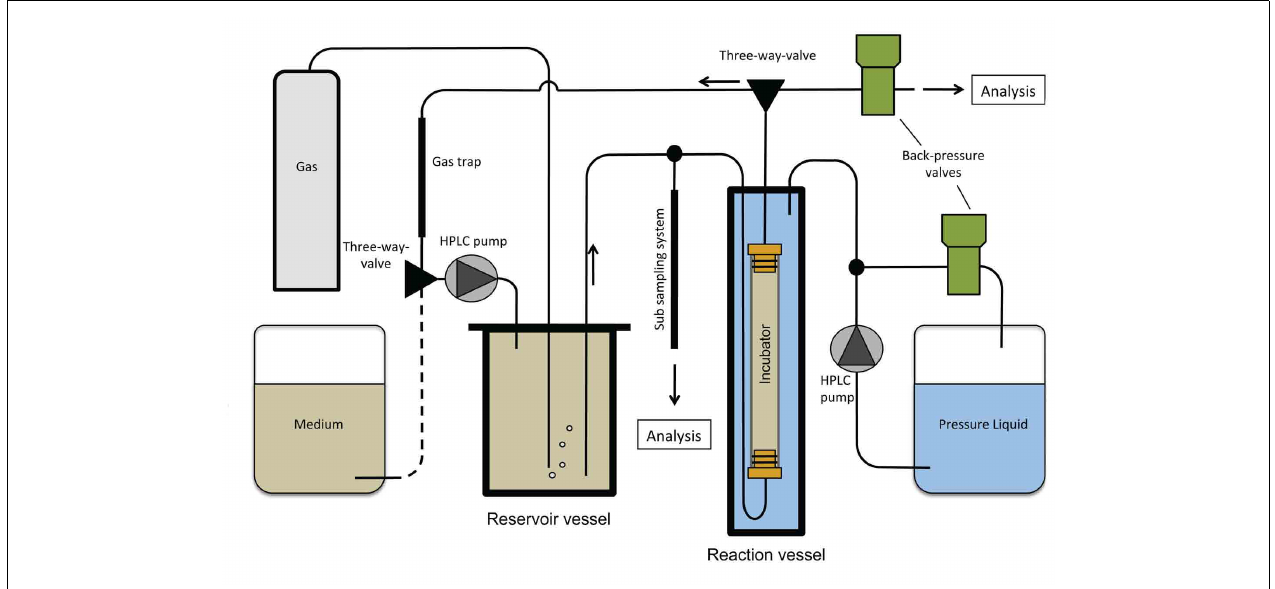
FIGURE 1 | Schematic drawing of the high-pressure incubation system. The medium is pressurized and enriched with gas in the reservoir vessel prior to flowing through the incubator sleeve that hangs inside the reaction vessel. Pressure in the reaction vessel is set and kept constant by a HPLC pump and a backpressure